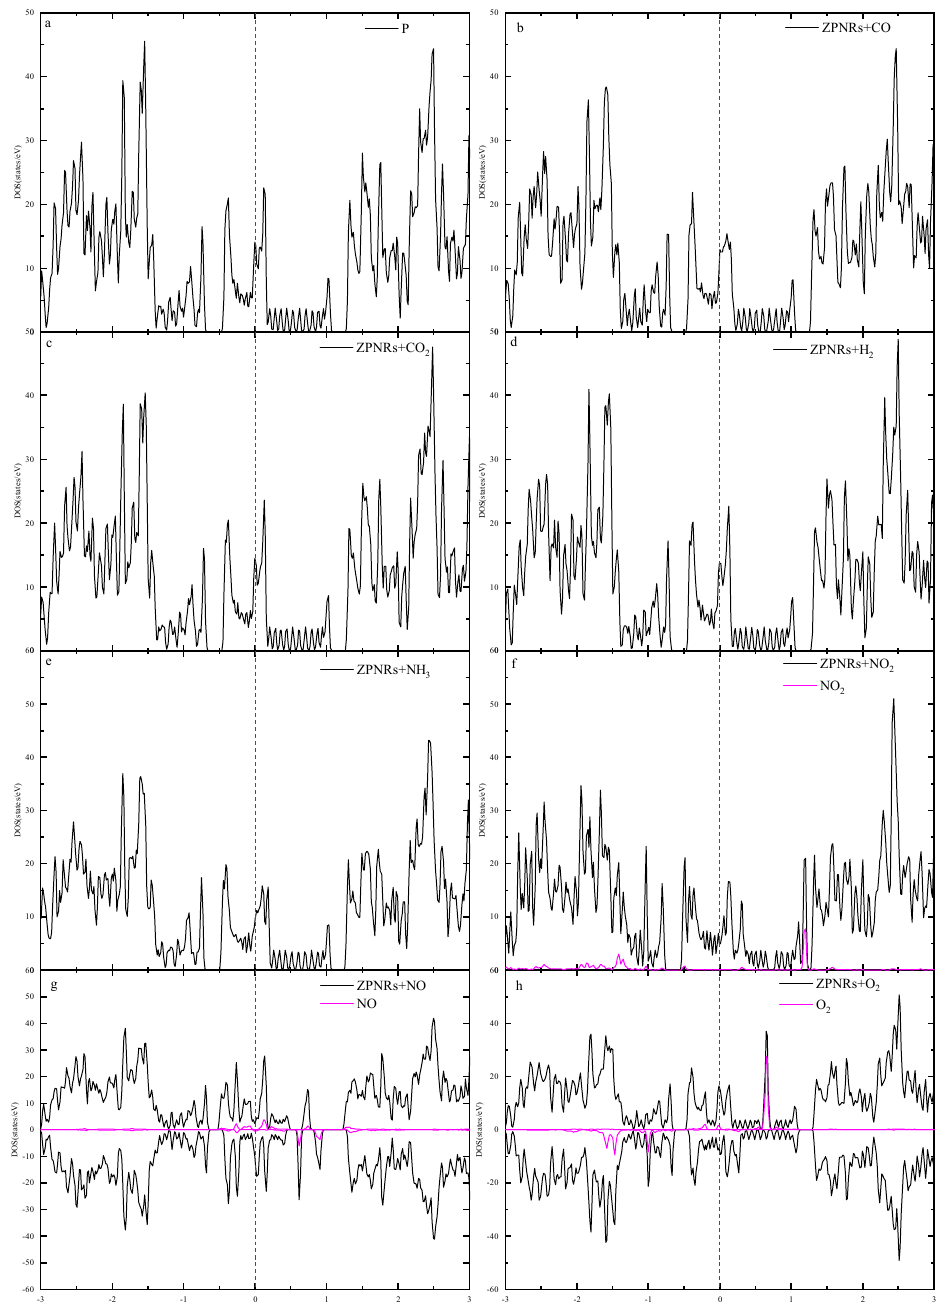
Figure 3. Density of states (DOS) of ZPNR ( a ) and the projected density of states (PDOS) of CO ( b ), CO 2 ( c ), H 2 ( d ), NH 3 ( e ), NO 2 ( f ),NO ( g ) and O 2 ( h ) adsorbed on the ZPNRs.